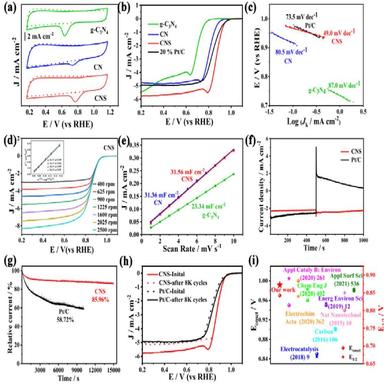
(a) CV curves of g-C3N4, CN, and CNS in N2- (dotted-line) and O2 (full-line)-saturated 0.1 M KOH electrolyte; (b) LSV curves and (c) Tafel slopes of g-C3N4, CN, CNS, and Pt/C samples; (d) LSV curves of CNS tested at 400e2500 rpm, inset: corresponding linearly fitted K-L curves at different potentials; (e) Double-layer capacitance calculations of g-C3N4, CN, and CNS catalysts; (f) Chronoamperometric tests of CNS and Pt/C catalysts in O2-staurated 0.1 M KOH electrolyte with 3 M CH3OH solution added at 500 s;